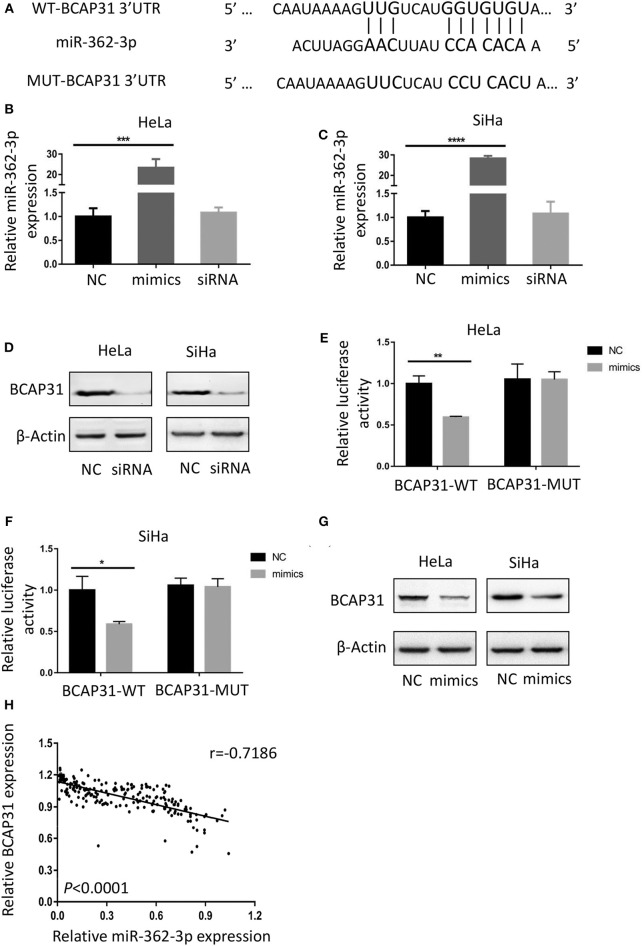
BCAP31 is a direct target of miR-362-3p in cervical cancer. (A) Complementarity of the 3′-UTR of wild-type (WT) or mutant (MUT) human BCAP31 mRNA (starting at nucleotide +417) with the miR-362-3p seed sequence. (B,C) qRT-PCR analyses for miR-362-3p expression following transfection of miR-362 mimics, NC (negative control) and siRNA of BAP31 into HeLa of SiHa cells, U6 RNA was used as control. (D) Western blotting results of BCAP31 expression following transfection of NC (negative control) and siRNA into HeLa or SiHa cells, β-Actin was used as control. (E,F) Relative luciferase activity in HeLa and SiHa cell line co-transfected with negative control/miR-362-3p mimics and BCAP31-WT/MUT vector. (G) Western blotting results of BCAP31 expression following transfection of NC (negative control) and miR-362-3p mimics into HeLa or SiHa cells, β-Actin was used as control. (H) An inverse correlation between miR-362-3p and BCAP31 expression in cervical cancer tissues. *P < 0.05; **P < 0.01; ***P < 0.001; ****P < 0.0001. Datas are represented as the mean ± s.d. of three independent experiments.